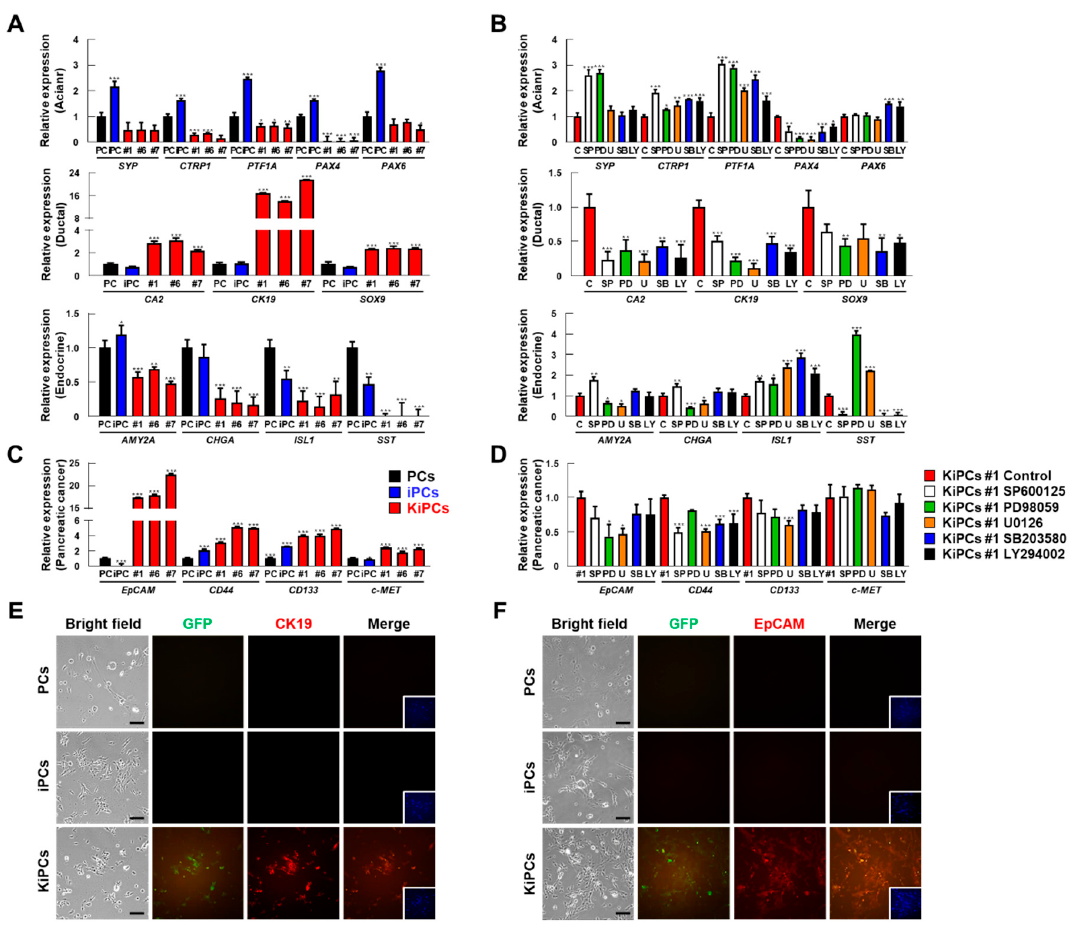
Figure 5. Gene expression analysis of pancreatic-specific markers and pancreatic cancer stem cell markers in KiPCs. ( A ) qPCR analysis of specific molecular markers of pancreatic acinar, ductal, and endocrine lineages in the indicated groups. ( B ) qPCR analysis of specific molecular markers of pancreatic acinar, ductal, and endocrine lineages after treatment with MAPK inhibitors in KiPCs #1. SP600125: 20 µ M, PD98059: 20 µ M, U0126: 10 µ M, SB203580: 10 µ M, LY294002: 10 µ M. ( C ) qPCR analysis of specific molecular markers of pancreatic cancer markers in the indicated groups. ( D ) qPCR analysis of specific molecular markers of pancreatic cancer after treatment with MAPK